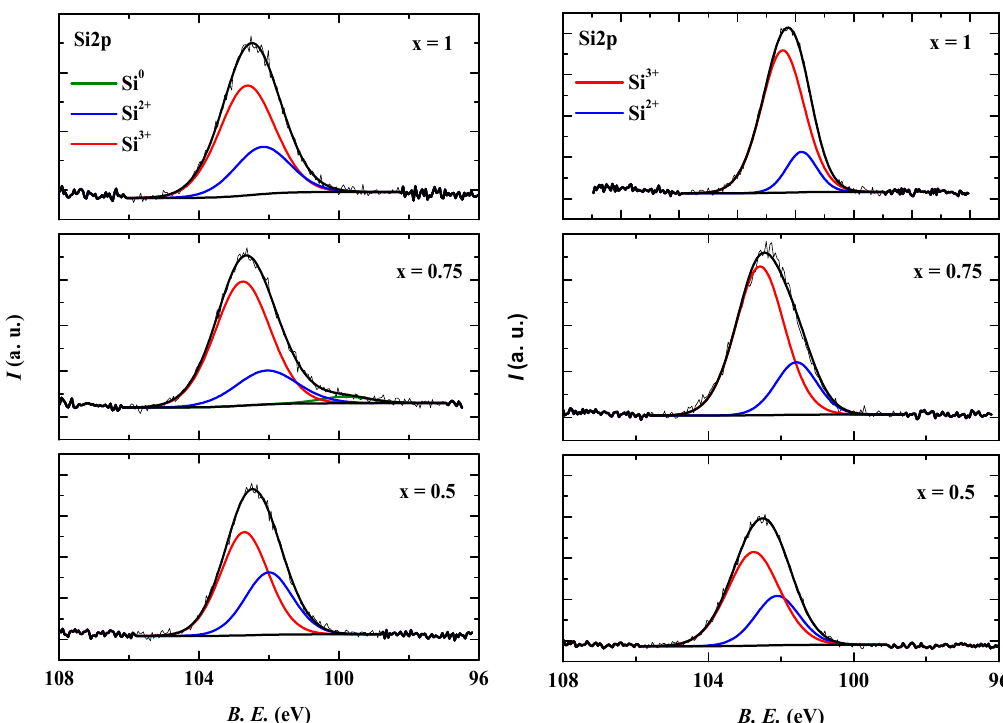
Figure 5. Ti2p, O1s and Si2p XP spectra of the investigated